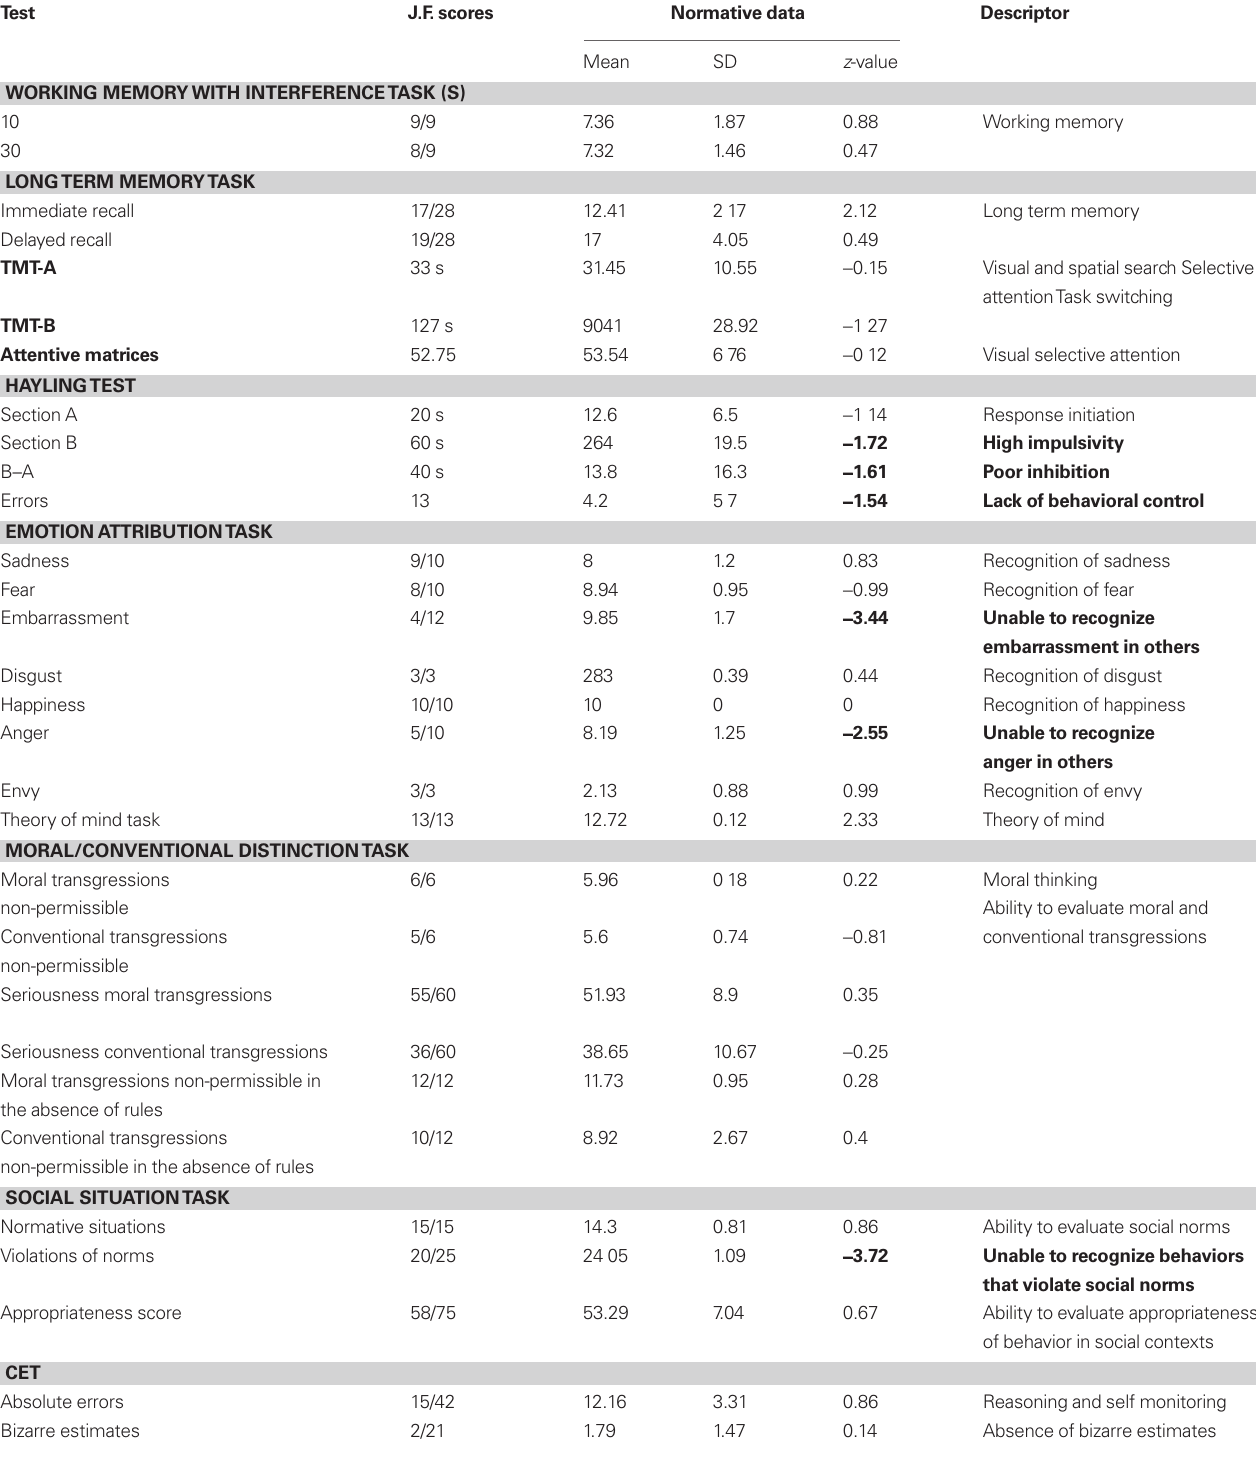
Table 2 | J.F.’s scores on neuropsychological tests were compared to normative data of each test. Test J.F.